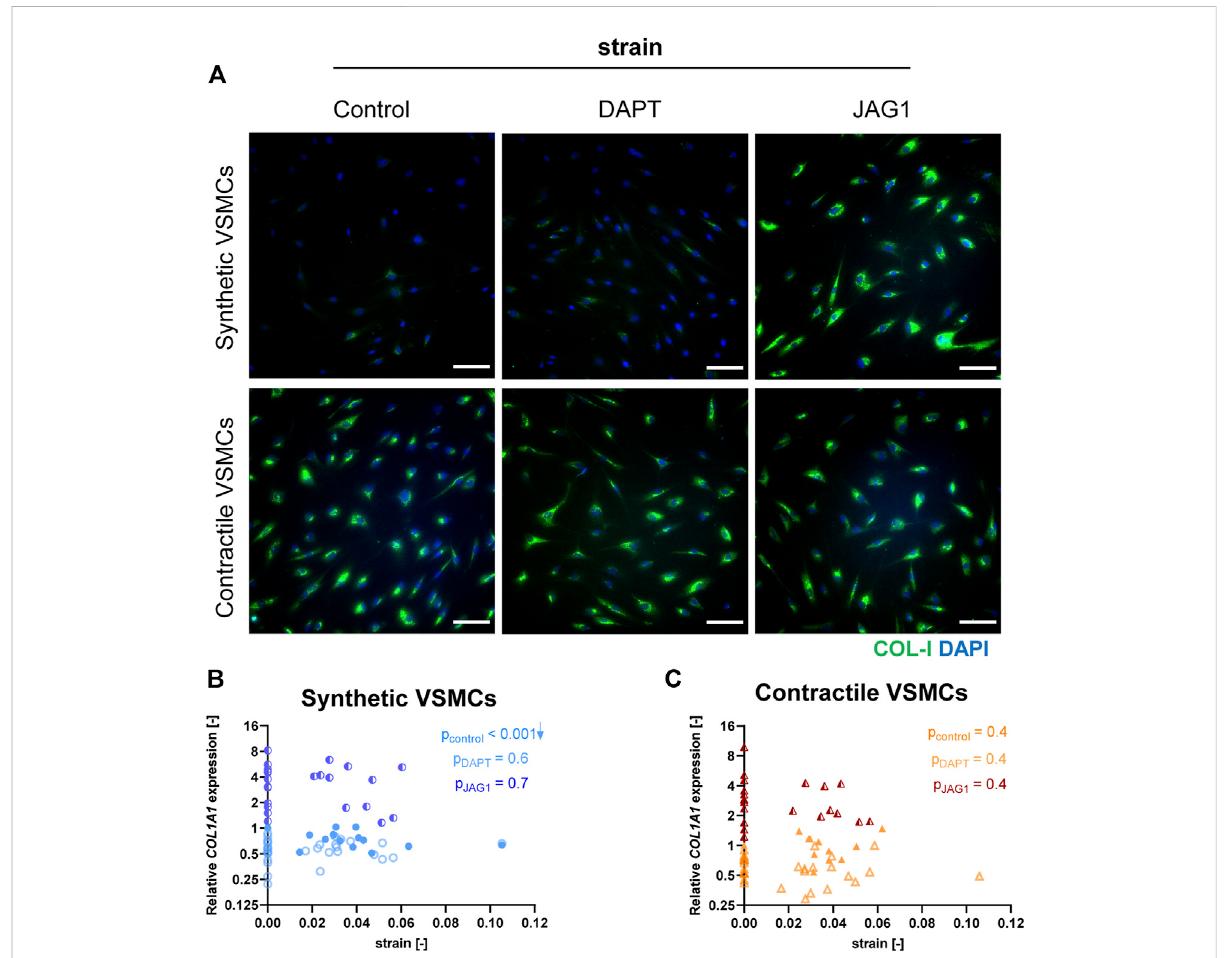
FIGURE 10 The impact of Notch signal inhibition and activation on strain-mediated changes in ECM production. (A) Representative IF images of collagen I (green) and nuclei (blue) for control, DAPT-treated and JAG1-induced synthetic and contractile VSMCs upon the application of 0.04 (4%) strain for 48 h (scale bar: 100 µm). Gene expression of ECM components (B,C) COL1A1 , (D,E) COL3A1 , (F,G) COL4A1 and (H,I) FN for control, DAPT-treated andJAG1-induced (B,D,F,H) syntheticVSMCs(bluecircles)and (C,E,G,I) contractileVSMCs(orangetriangles)asafunctionofstrain(normalized to static control expression). p values show the signi fi cancelevel of non-parametric Spearman correlation coef fi cient. The arrows next to signi fi cant correlations ( p < 0.05 ) demonstrate an up or downregulation in gene expression with applied strain